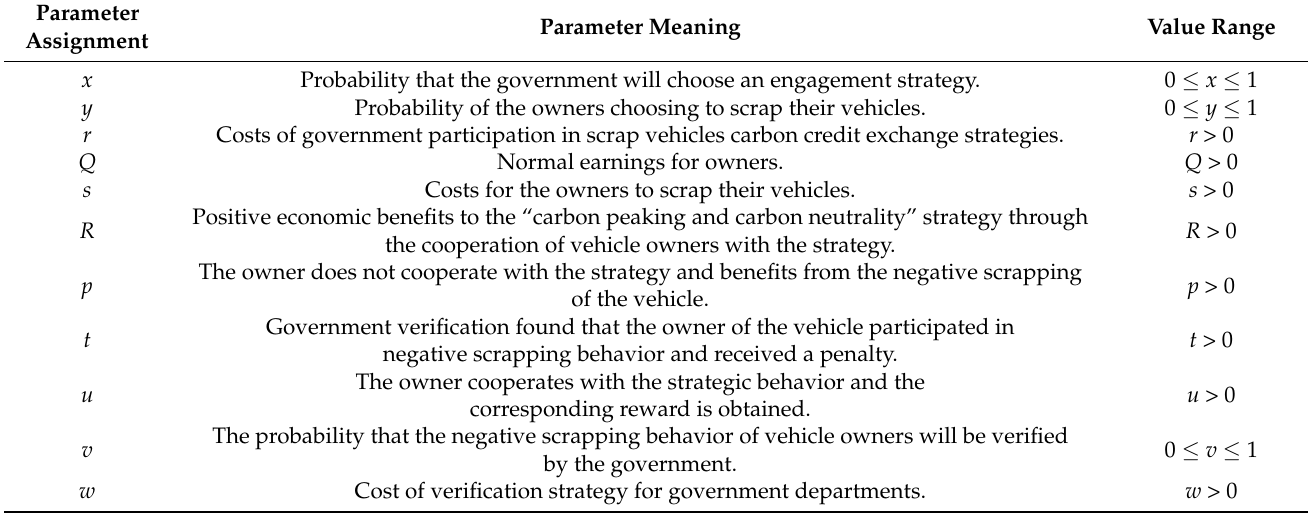
Table 1. Model parameter assignment table.